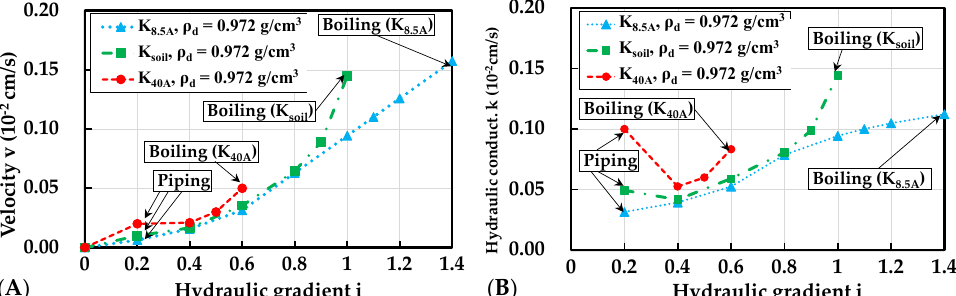
Figure 7. Piping test results of Komaoka volcanic soil, ( A ) velocity ( B ) and hydraulic conductivity [32].